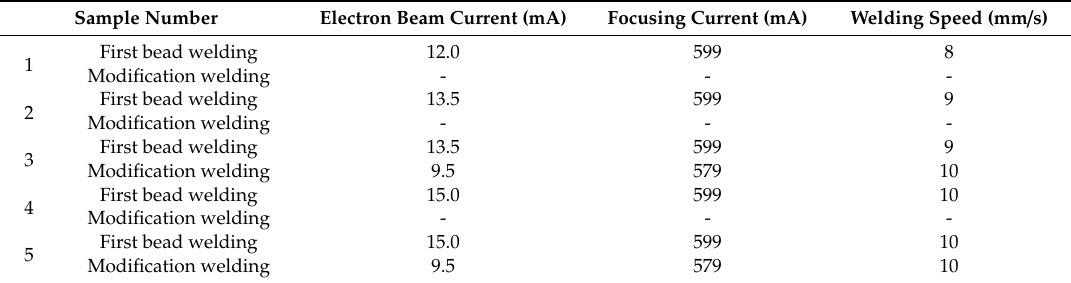
Table 1. Electron beam welding parameters of 7055